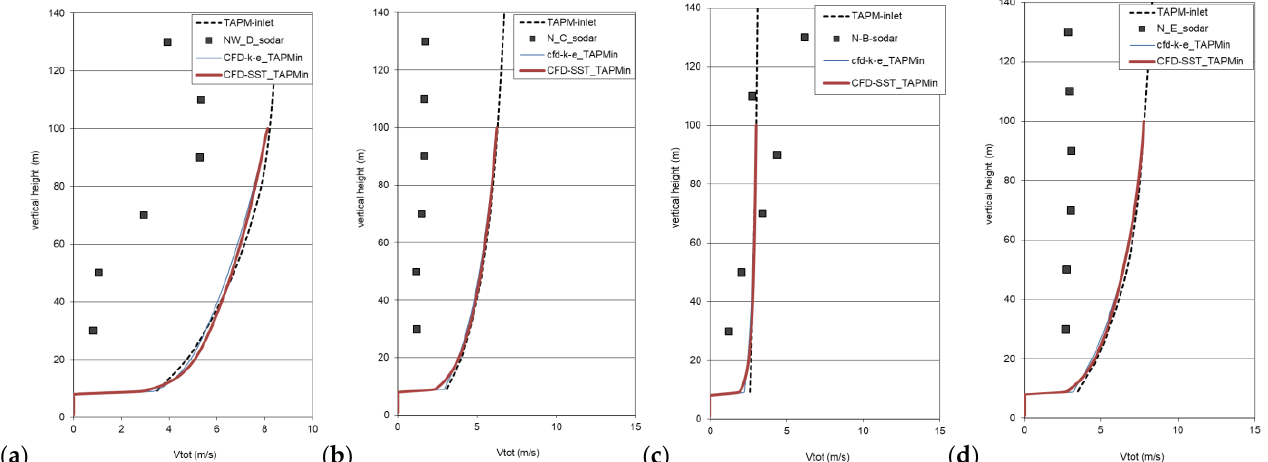
Figure 5. Vertical profiles of wind speed over position 2 (Figure 1) at four stability conditions ( a ) D, ( b ) C, ( c ) B, ( d ) E (Table 1). Comparison of CFD results using two different turbulence models (k- ε and SST) and SODAR measurements. Mesoscale results (“TAPM - inlet”) are also shown.